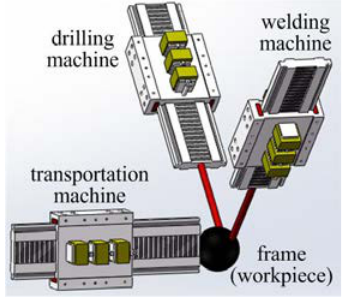
Figure 1. Coordination of linear machines.